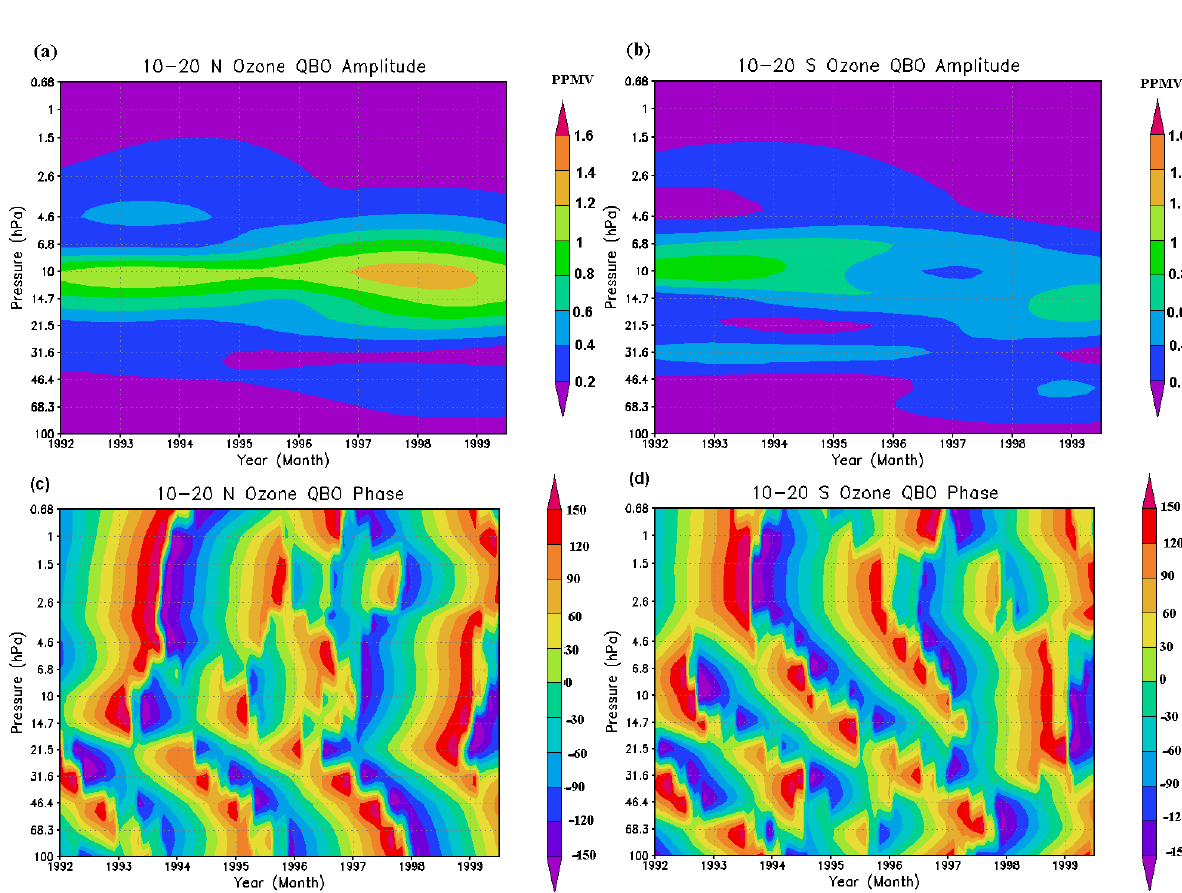
Fig. 4. Variation of amplitude of ozone QBO in time-height domain over (a) 10–20 ◦ N and (b) 10–20 ◦ S. Variation of phase of ozone QBO in time-height domain over (c) 10–20 ◦ N and (d) 10–20 ◦